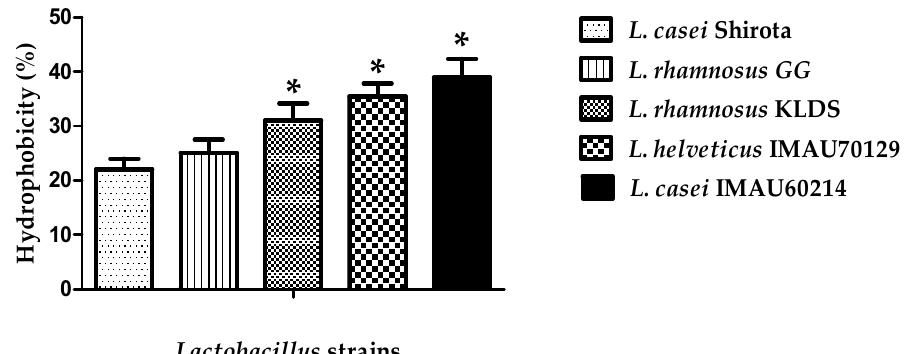
Figure 1. Lactobacillus strain hydrophobicity determined in xylene presence (1 h). Values are expressed as mean ± standard deviation (SD) in three different experiments. * significant difference among strains p < 0.05.